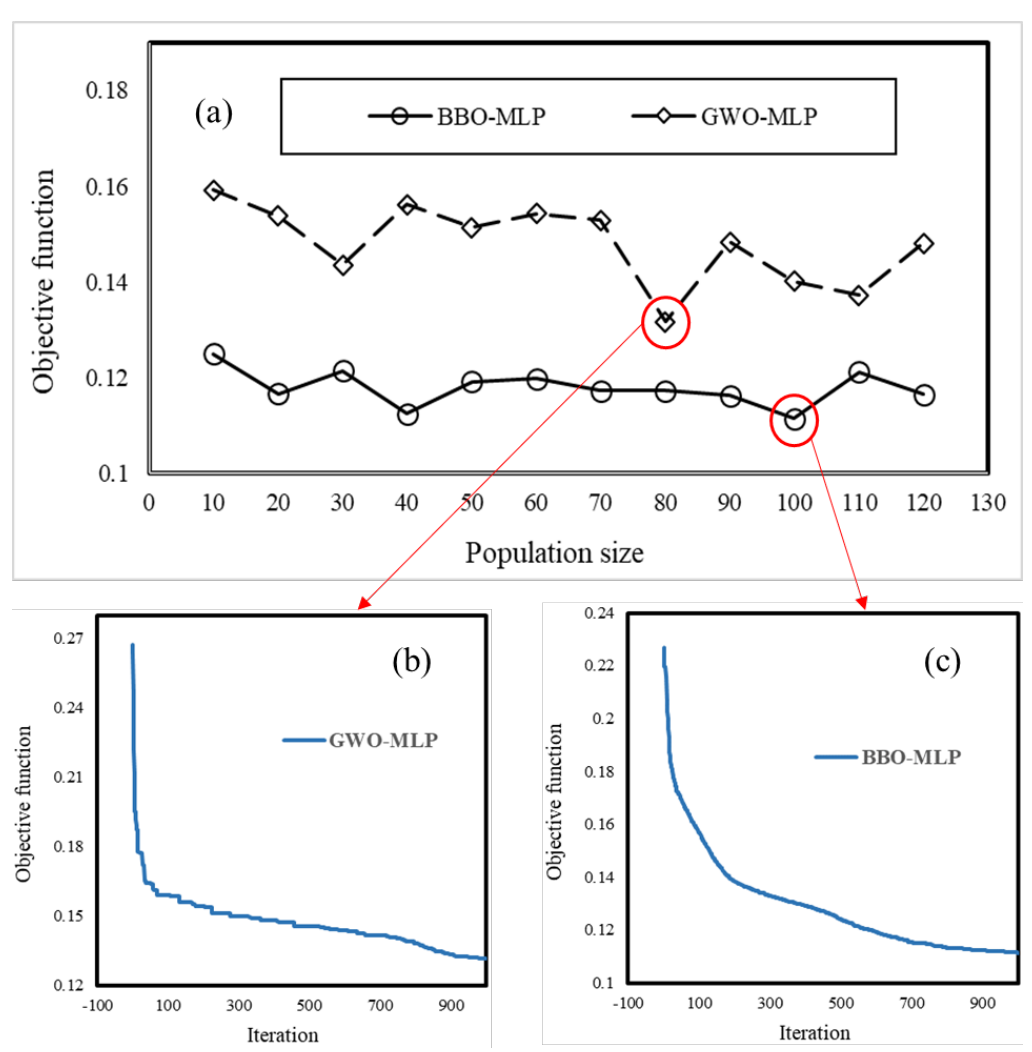
Figure 9. ( a ) The results of the executed sensitivity analysis, ( b , c ) the convergence curve of the elite GWO-MLP and BBO-MLP, respectively.